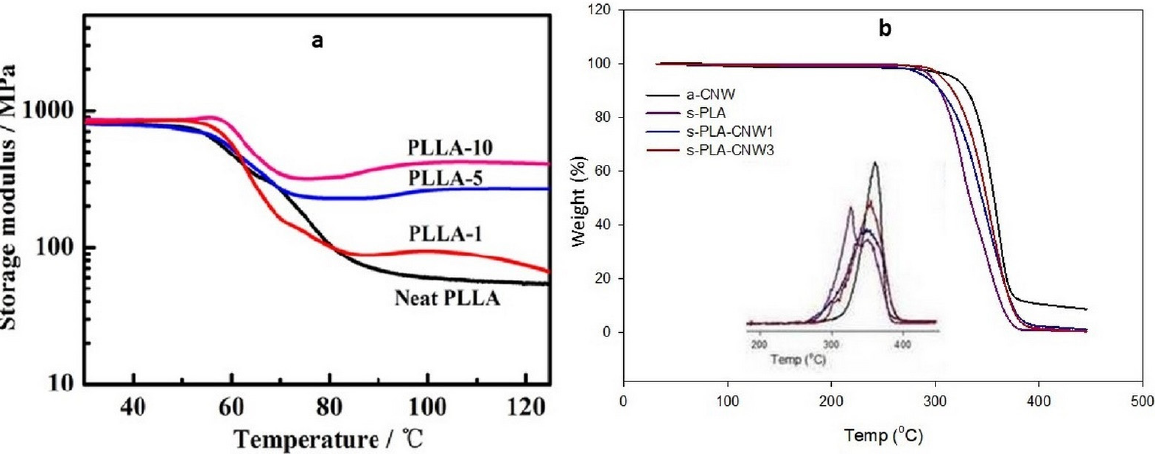
Figure 7. ( a ). Storage modulus 9E’—temperature curve of neat PLLA and CNW-grafted-PLLA at different content (PLLA-1; PLLA-5; and PLLA-10) [103]; ( b ). TGA traces of a-CNW, s-PLA, and